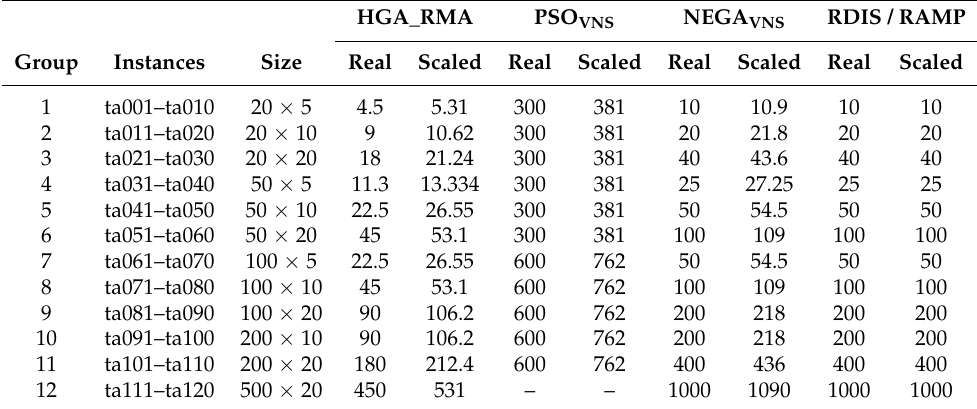
Table 3. Comparison of maximum allowed running times for different metaheuristics.